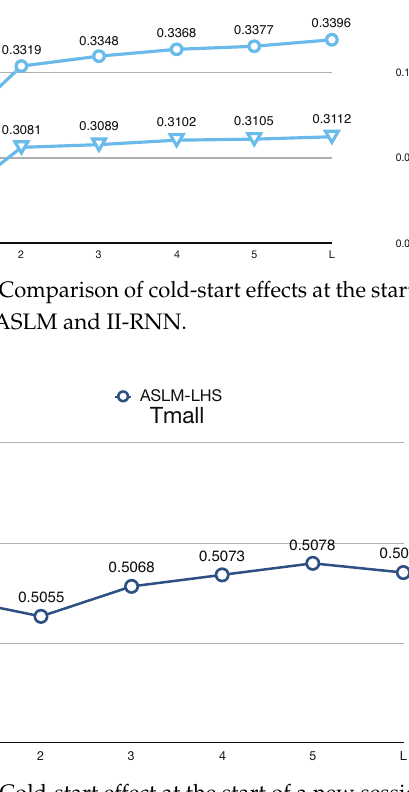
Figure 2. Cold-start effect at the start of a new session for the Tmall dataset. Please note that no data are provided for the cold-start problem by the SWIWO